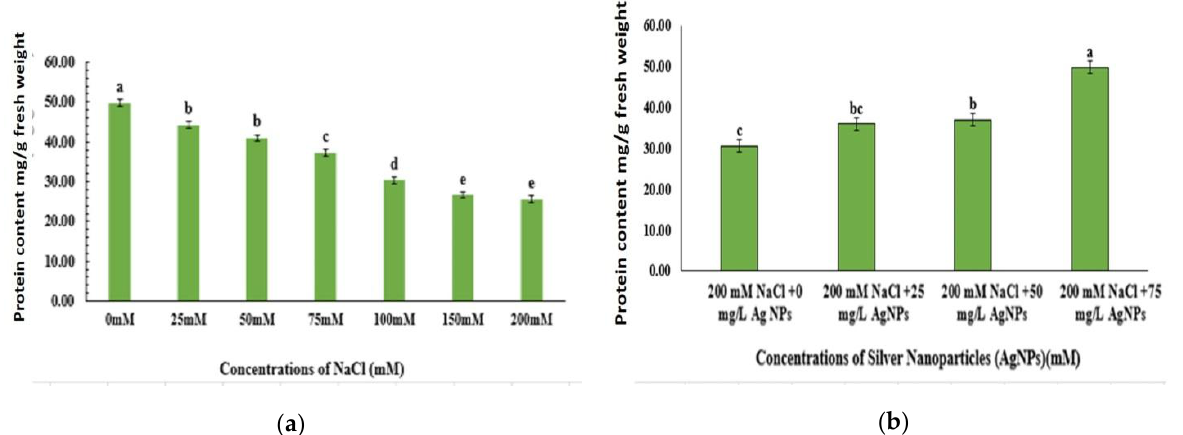
Figure 2. Protein content (mg/g FW) of the Q6 quinoa plantlets. ( a ) Effect of different NaCl levels on protein content (mg/g FW) of the Q6 quinoa plantlets; ( b ) effect of adding different levels of Ag NPs on the protein content of the Q6 quinoa plantlets grown under the highest NaCl level (200 mM). Data are the means ± SE of three replicates. Different letters within the columns indicate the means that have a significant difference at the p ≤ 0.05 probability levels. Vertical bars represent the standard error at the p ≤ 0.05 probability levels.